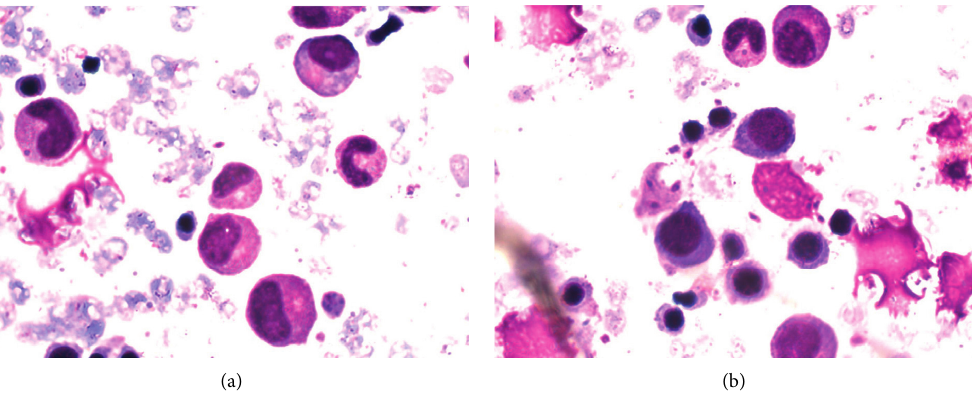
Figure 1: (a)-(b) Microscopic identification of Leishmania parasite in bone marrow